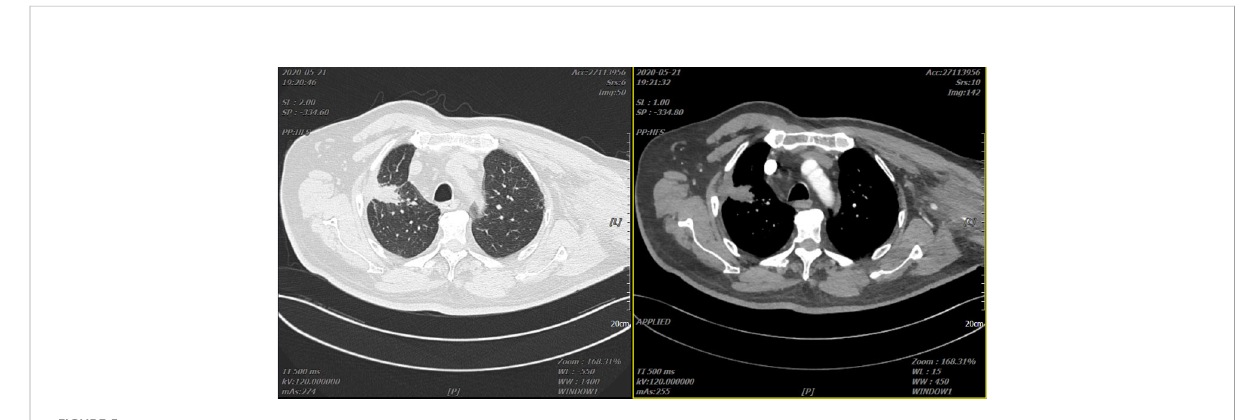
FIGURE 5 Two representative CTs of the patient on 21 May 2020.